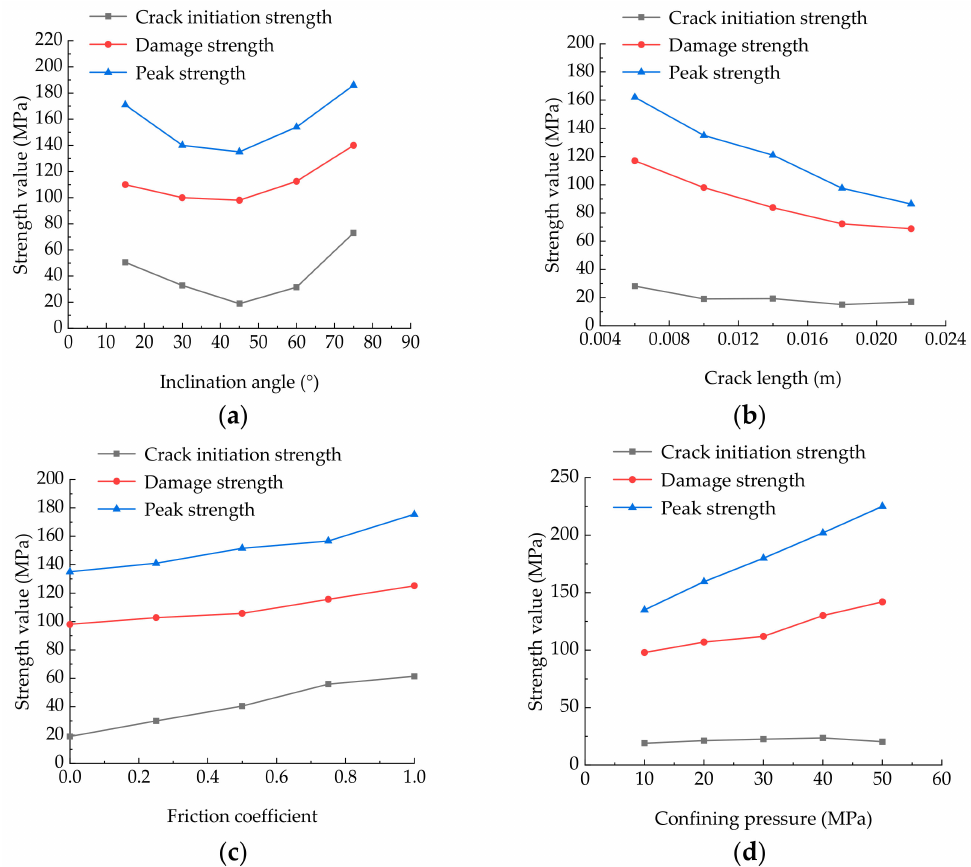
Figure 15. Variation of characteristic rock strength under different conditions: ( a ) inclination angle of main crack; ( b ) main crack length; ( c ) friction coefficient; ( d ) confining